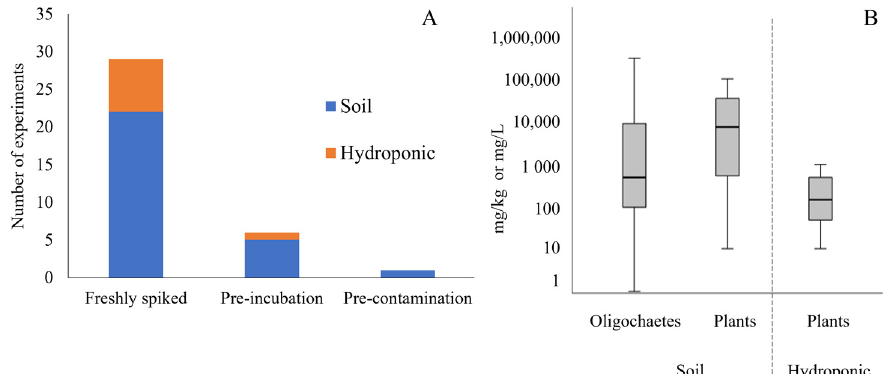
Figure 3. ( A ) Number of experiments in soil and hydroponic mediums using different spiking procedures. ( B ) Box plot of nano- and microplastic (NMP) concentration in soil (mg NMP/kg) and hydroponic (mg NMP/L) exposures.